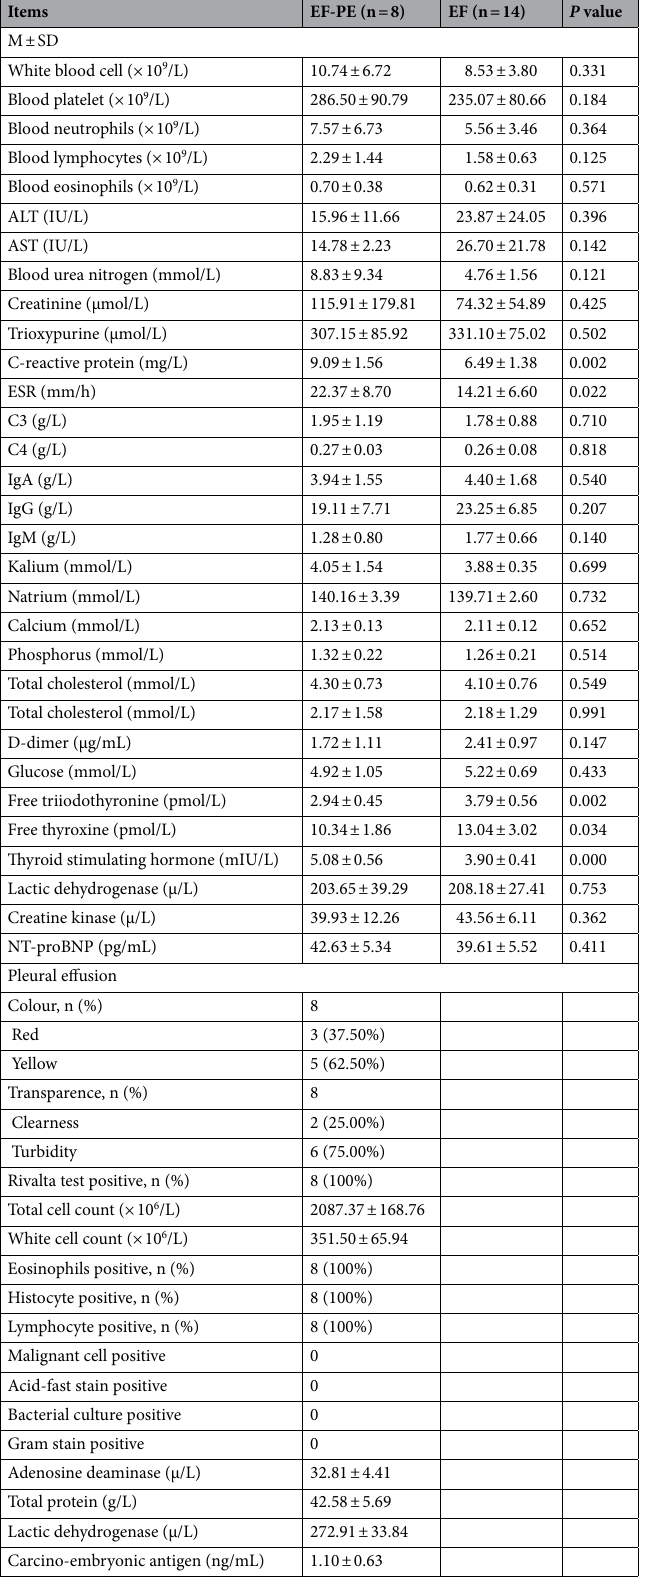
Table 3. Laboratory indicators of the two groups. Comparisons were determined by Student’s t test or the Mann–Whitney U test. P < 0.05 was considered statistically significant. ESR erythrocyte sedimentation